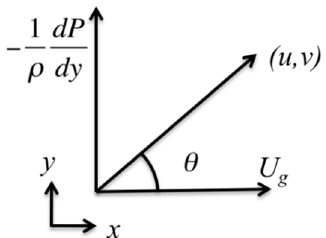
Figure 1. Projection of the geostrophic wind on the wind direction.